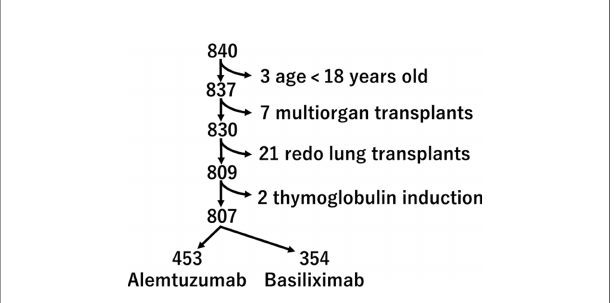
FIGURE 1 | Algorithm of selection of study